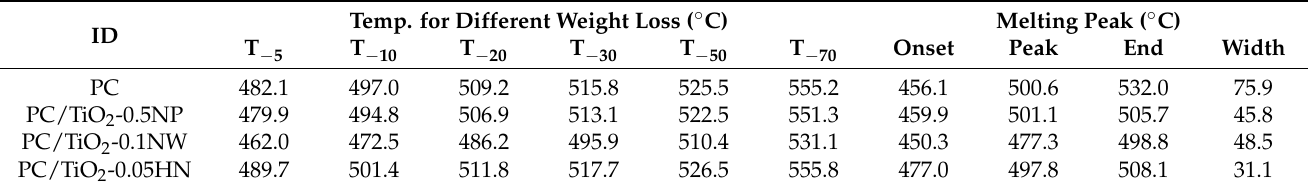
Table 2. Temperatures corresponding to different weight losses from TGA results and DSC data for the as-received PC and different PC/TiO 2 composites.